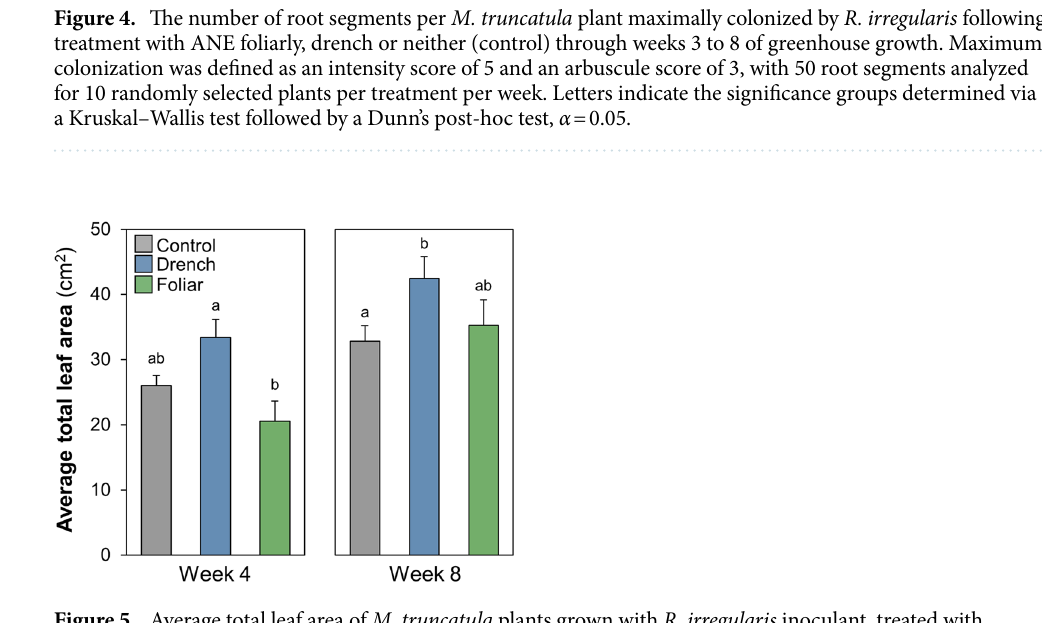
Figure 5. Average total leaf area of M. truncatula plants grown with R. irregularis inoculant, treated with nutrients only (control) or with ANE foliarly or via drench. Letters indicate Tukey’s post-hoc test significance groups, α = 0.05, following analysis of variance, with 10 plants measured per